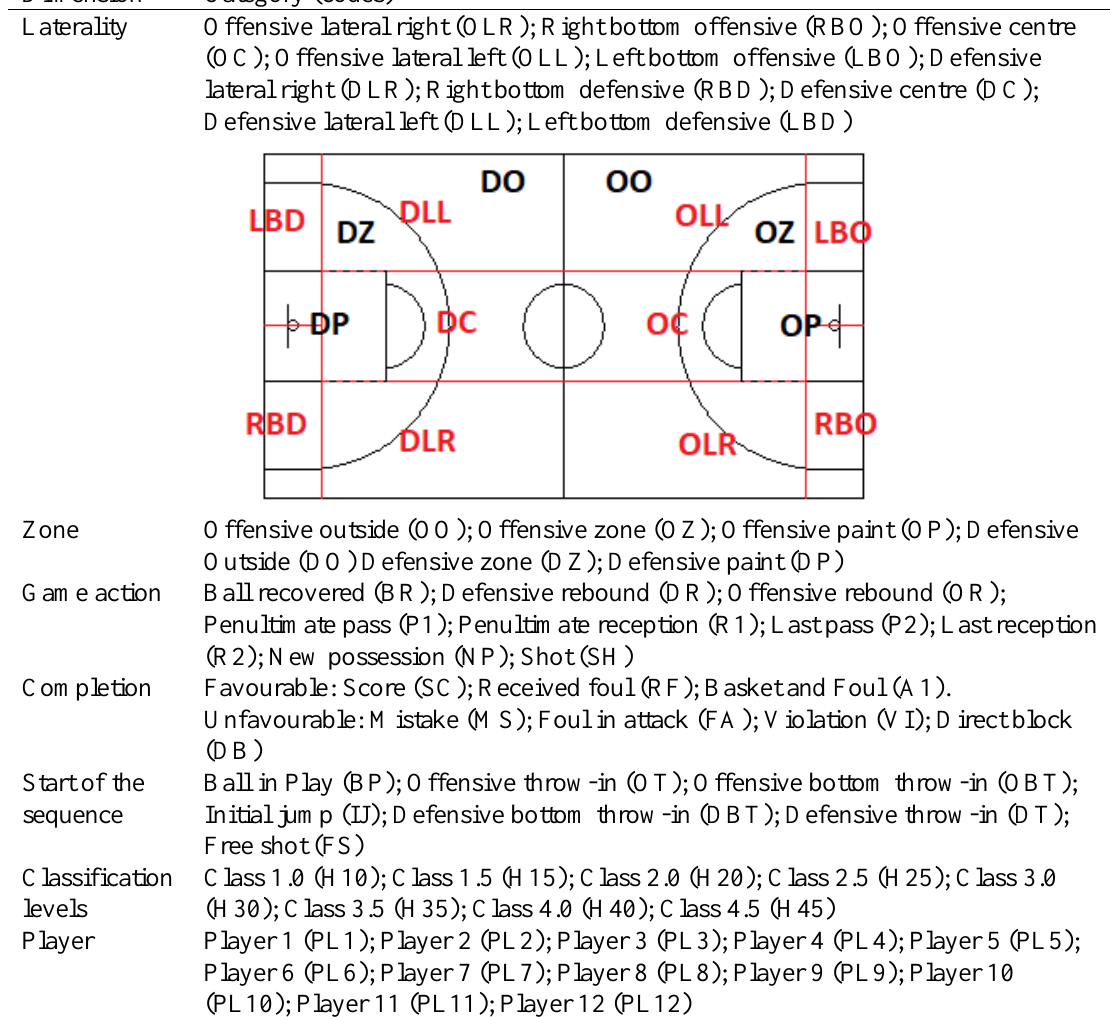
Table 1. Observation instrument